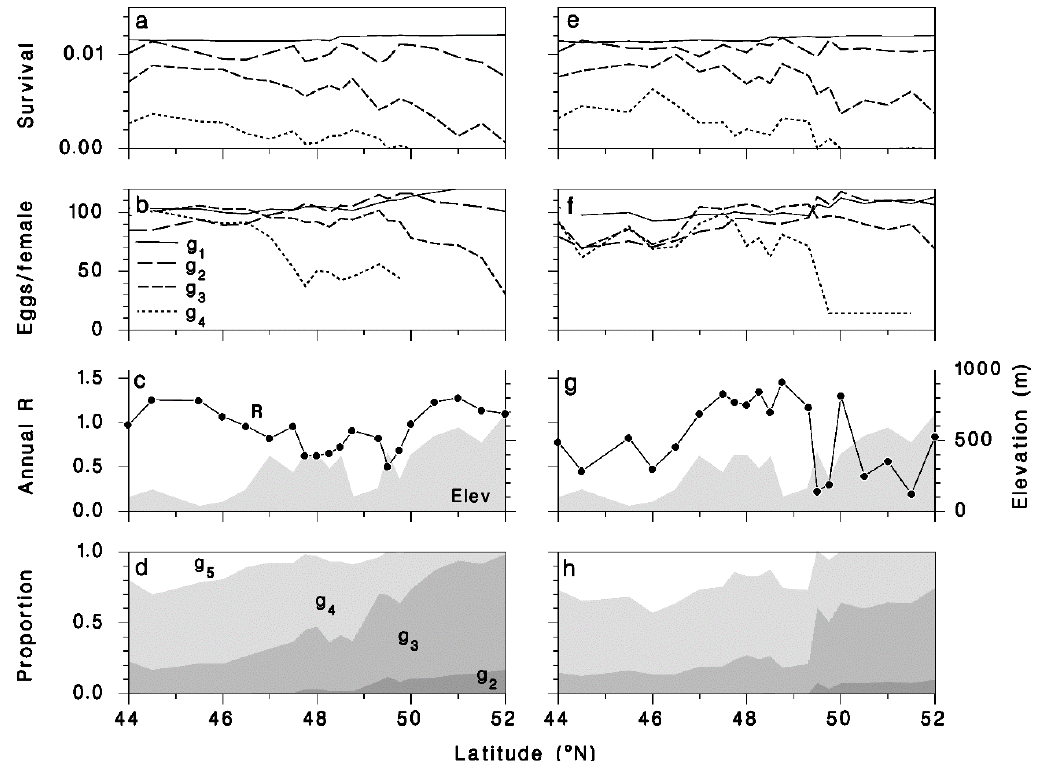
Figure 10. Summary of model output along the north-south transects under ( a – d ) 1981–2010 climate and ( e – h ) future climate (2011–2040). ( a , e ): Survival from egg to adult in each generation (g 1 to g 4